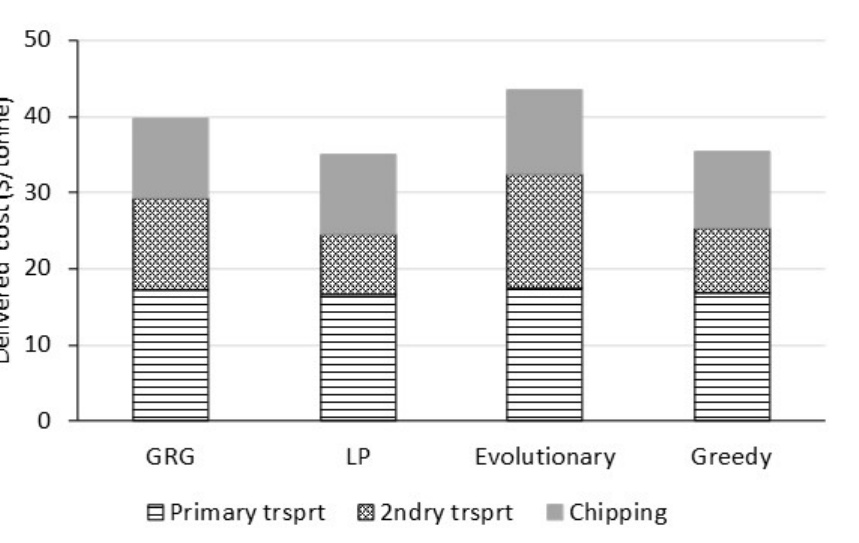
Table 5. Mean cost values for each tested method.